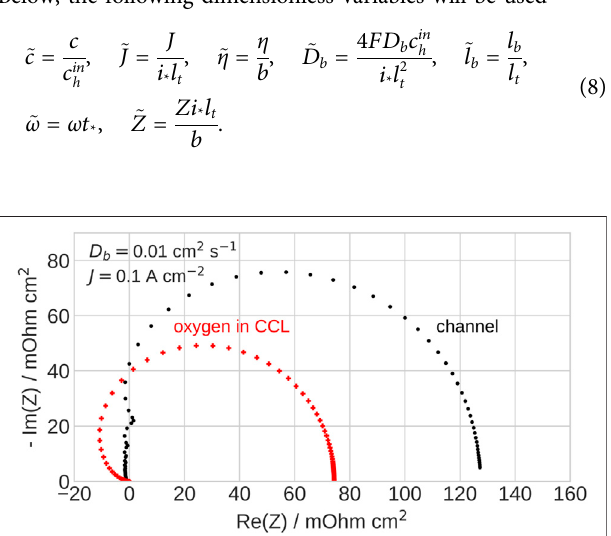
FIGURE 2 | Nyquist spectra of the channel impedance, Appendix Eq. A1 and of impedance of oxygen transport in the CCL (Kulikovsky, 2017).